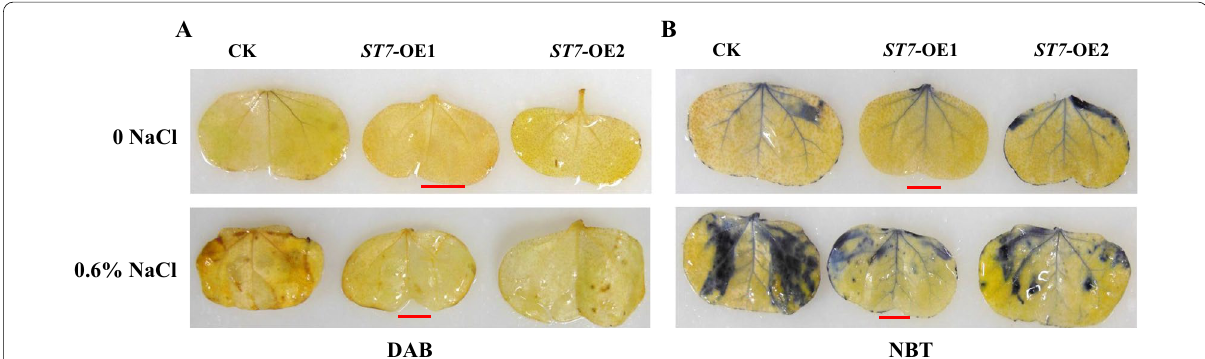
L − 1 NaCl for one day before DAB ·